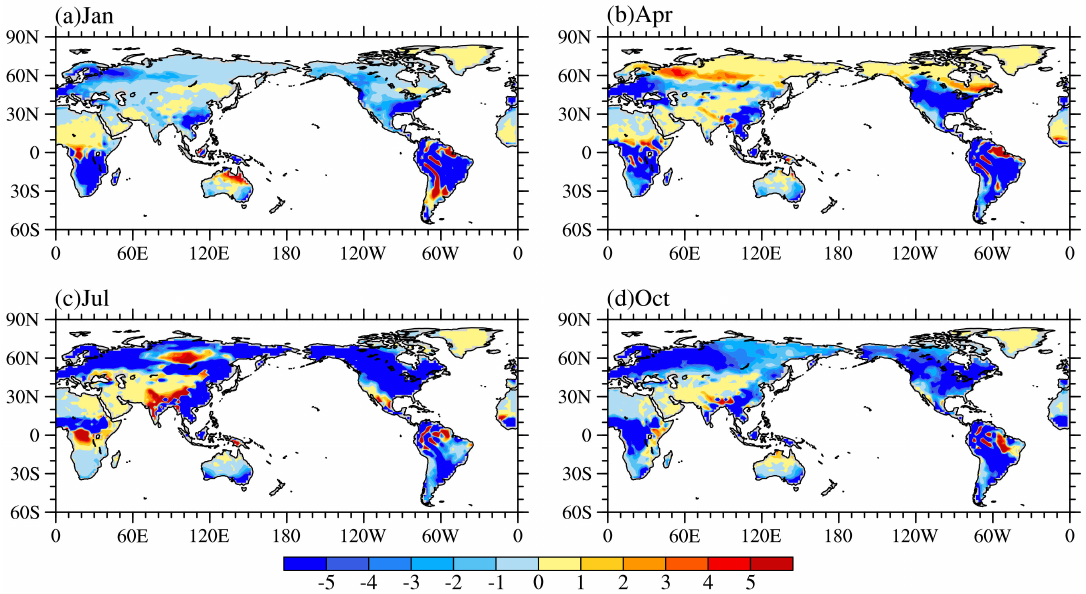
Figure 5. Difference in global Ec (units: W/m 2 ) between the simulation results of CLM4.5 and reanalysis (NOAA) in January ( a ), April ( b ), July ( c ) and October ( d ).